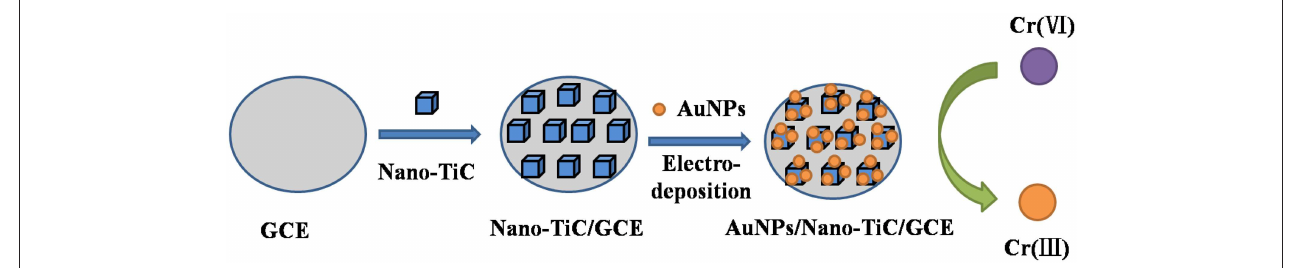
FIGURE 1 | Schematic illustration for the fabrication process of the proposed electrode designed for Cr (VI)